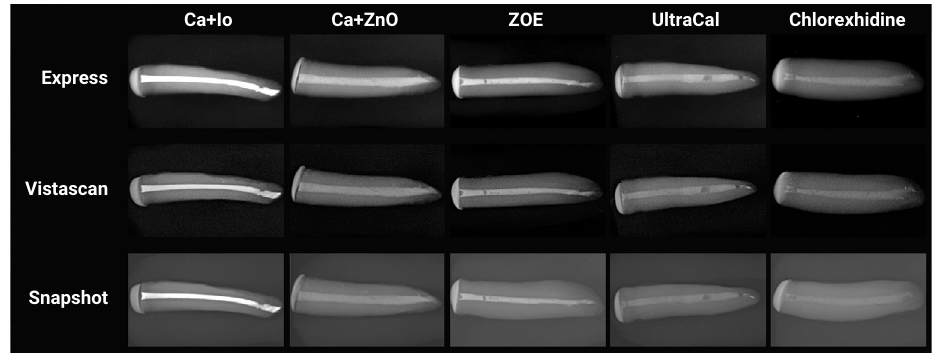
Figure 1. Cropped periapical radiographs of teeth with different intracanal materials obtained with the radiographic systems